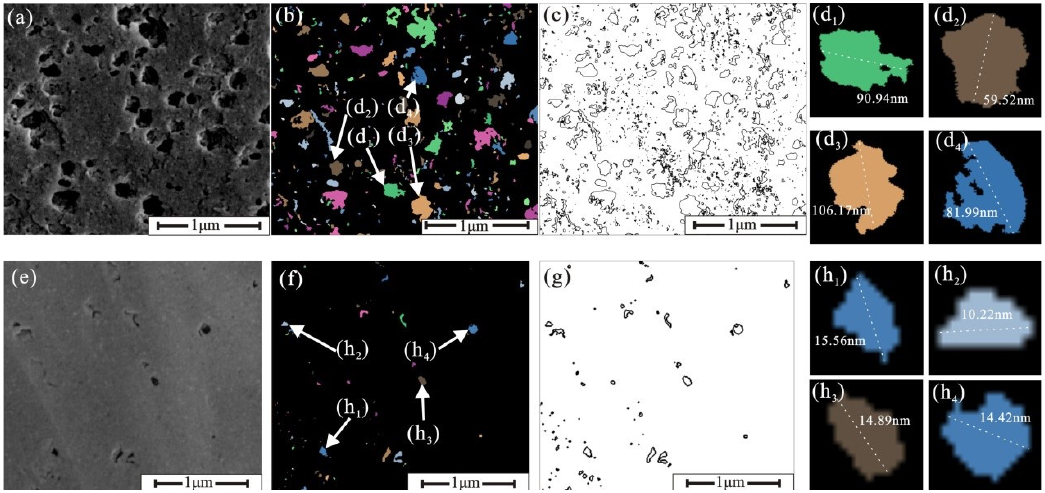
Figure 12. OM pores in the FE-SEM images of the Lower Paleozoic shale from the upper Yangtze plate (( a – d ), Longmaxi Fm shale sample; ( e – h ), Qiongzhusi Fm shale sample). Table 4. Characteristics of OM in the Lower Paleozoic shale from the upper Yangtze plate.